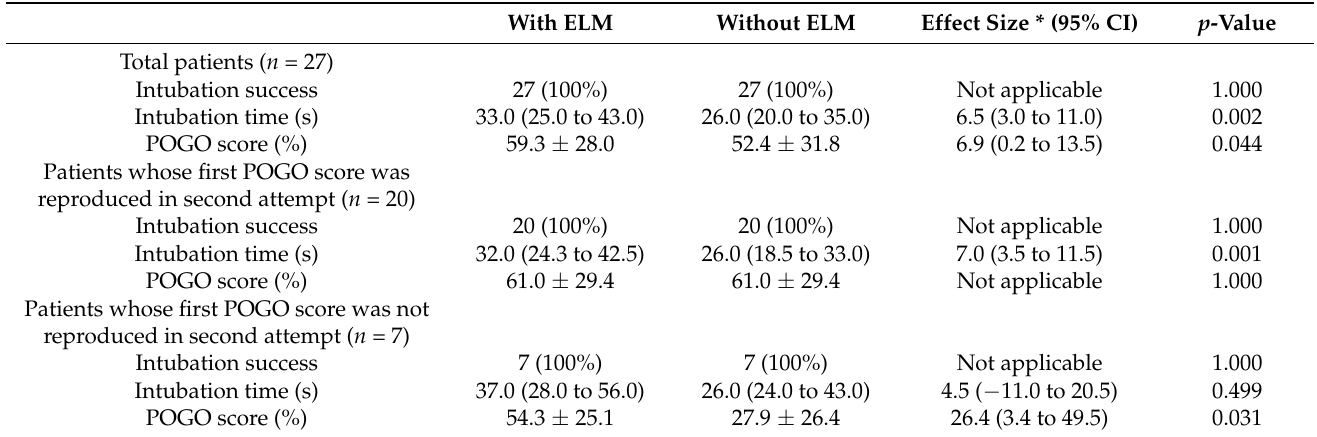
Figure 3. Cervical spine angle before and during intubation at the occiput-C1, C1–C2, and C2–C5 segments. * Means a significant difference in cervical spine angle with ELM (black colored circle) versus without ELM (white colored circle) external laryngeal manipulation. Table 3. Intubation